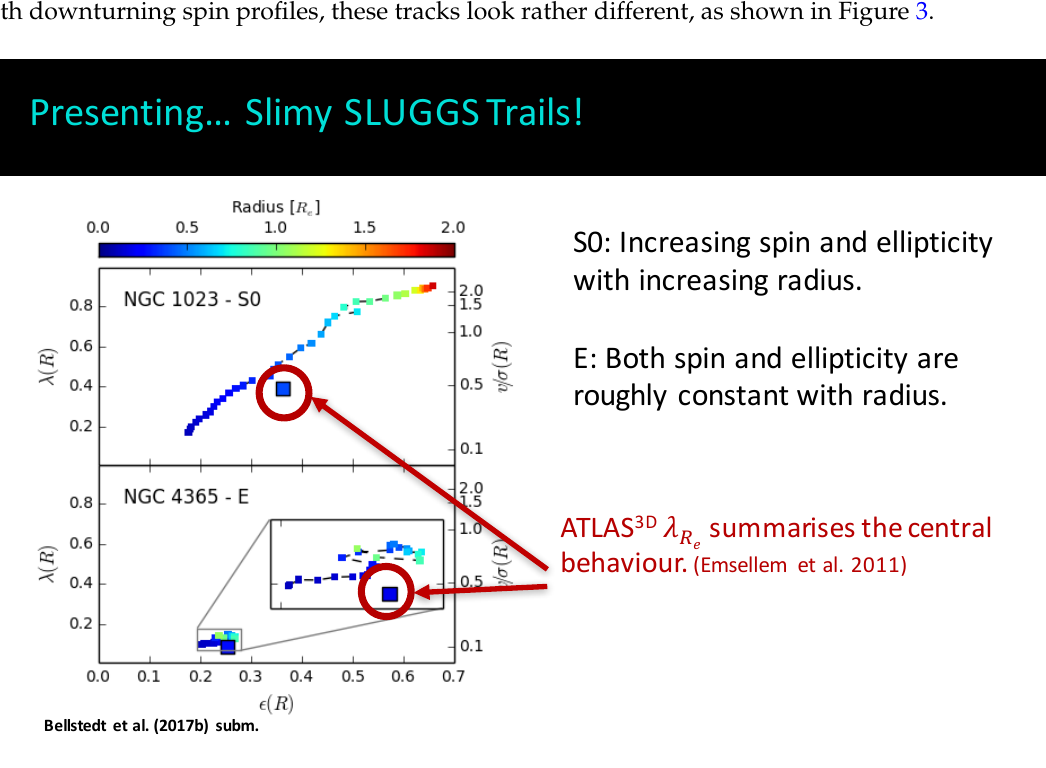
Figure 2. Example spin–ellipticity tracks for “typical” lenticular and elliptical galaxies. In addition to the SLUGGS tracks, we include the central aperture-based value from the ATLAS 3D Survey